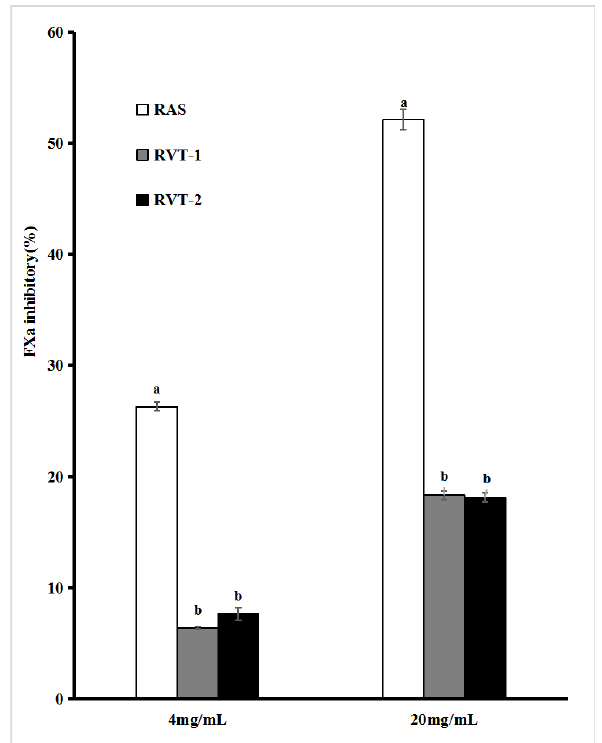
Figure 5. FXa inhibitory ability assays for RVT and RAS. Values with different letters within the same substance are significantly different ( p < 0.05). All data were expressed as the means ± SD, n = 3.